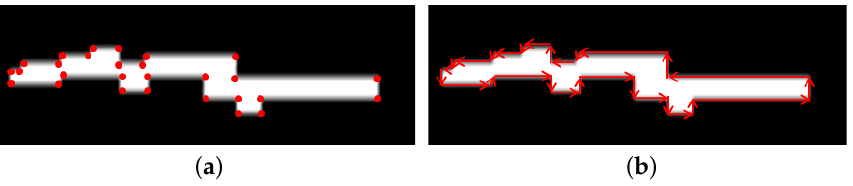
Figure 11. A sample pictorial view of the selected points in Φ A for the obstacle A . ( a ) Red dots are the points present in Φ A . ( b ) Vector formation using the points in Φ A